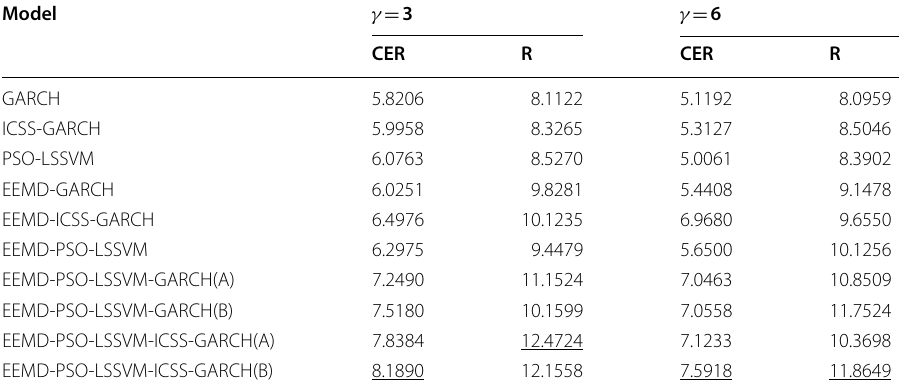
The underlined numbers indicate that the corresponding models have the highest R or CER among all models